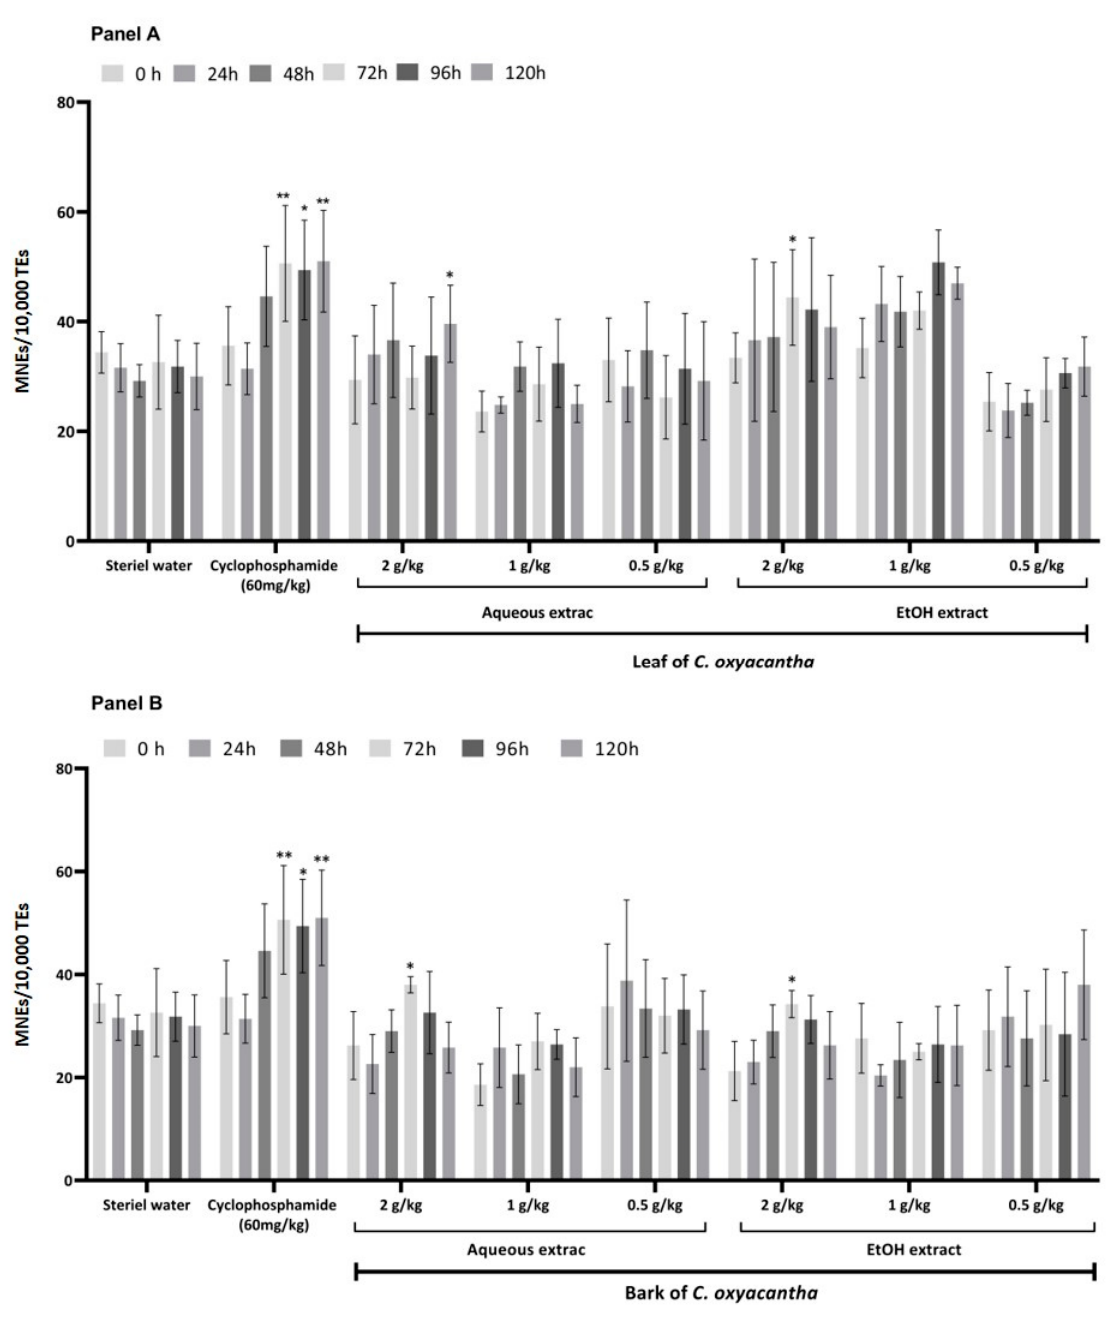
Figure 3. Proportion of MNEs in mouse peripheral blood in the study groups. Panel A shows the results obtained from the leaf and panel B those from the bark of C. oxyacantha. Intragroup comparisons were performed between baseline samples (0 h) against the following sampling times: 24, 48, 72, 96, and 120 h. MNEs, Micronucleus Erythrocytes; * p < 0.05; ** p <